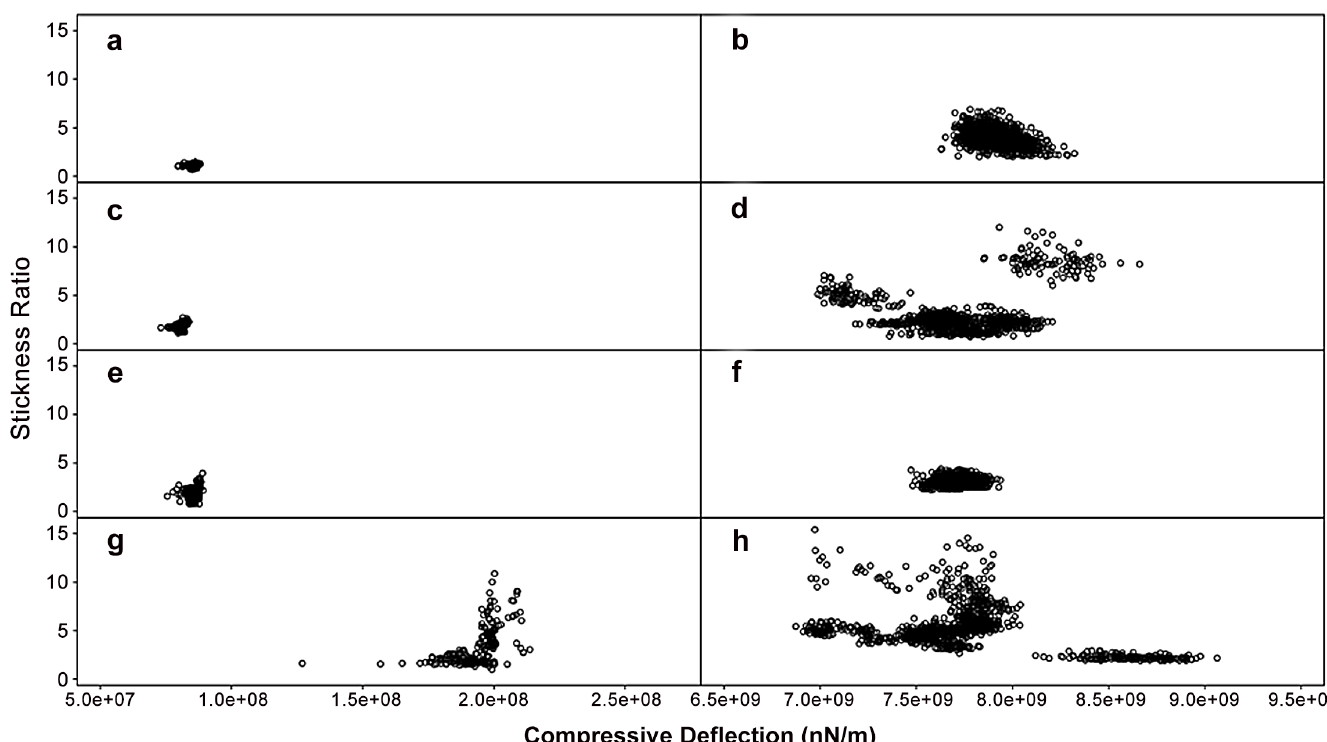
Fig 3. Stickiness ratios and compressive deflections of Escherichia coli K-12 MG1655 and Listeria innocua field strain. (a) E. coli wild-type, unexposed to AgNP. (b) L. innocua unmodified, unexposed to BAC. (c) E. coli wild-type, exposed to AgNP. (d) L. innocua unmodified, exposed to BAC. (e) E. coli resistant, unexposed to AgNP. (f) L. innocua with bcrABC, unexposed to BAC. (g) E. coli resistant, exposed to AgNP. (h) L. innocua with bcrABC, exposed to